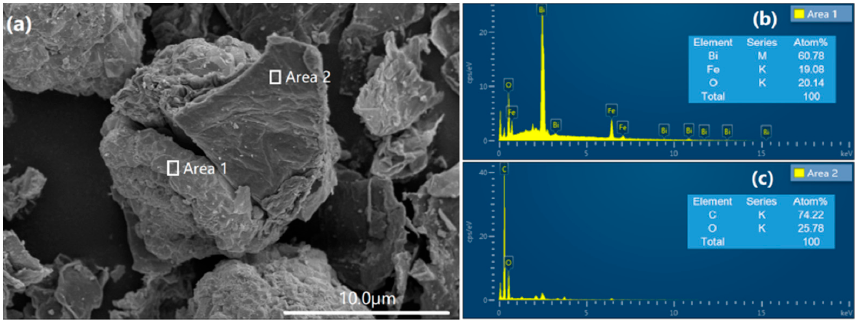
Figure 3. The magnification of ( a ) BGO60 composite; energy dispersive X-ray spectroscopy (EDS) spectrum of BGO60; ( b ) Area 1; ( c ) Area 2.